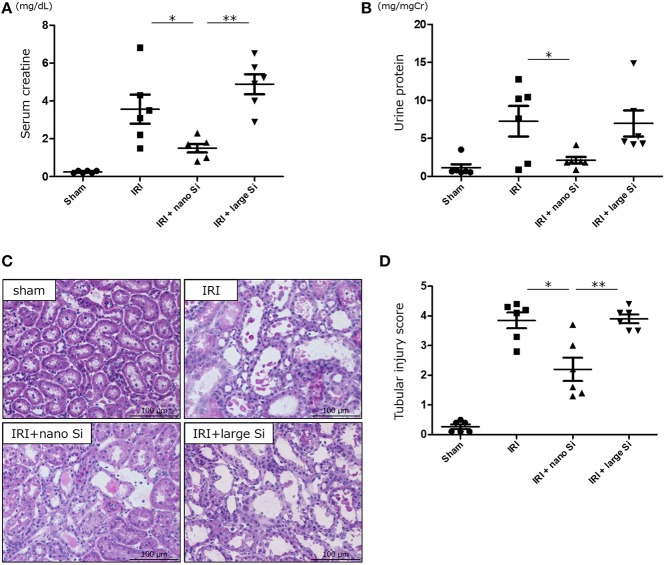
Oral administration of nano-sized silicon (Si) particles (nano-Si) improves renal function and tubular damage following ischemia-reperfusion injury (IRI). Serum creatinine (A) and urine protein levels (B) at 72 h after surgery for ischemia-reperfusion in animals receiving normal diet (IRI group) or a diet comprising nano-Si (IRI + nano-Si group) or large-sized Si (IRI + large-Si group) as well as those undergoing sham surgery (sham group). (C) Representative images of renal sections stained with hematoxylin and eosin at 72 h after surgery in the sham, IRI, IRI + nano-Si, and IRI + large-Si groups. (D) Semiquantitative analysis of the images using tubular injury score. Bars represent means ± standard error of the mean. *p < 0.05, **p < 0.01, n = 6.